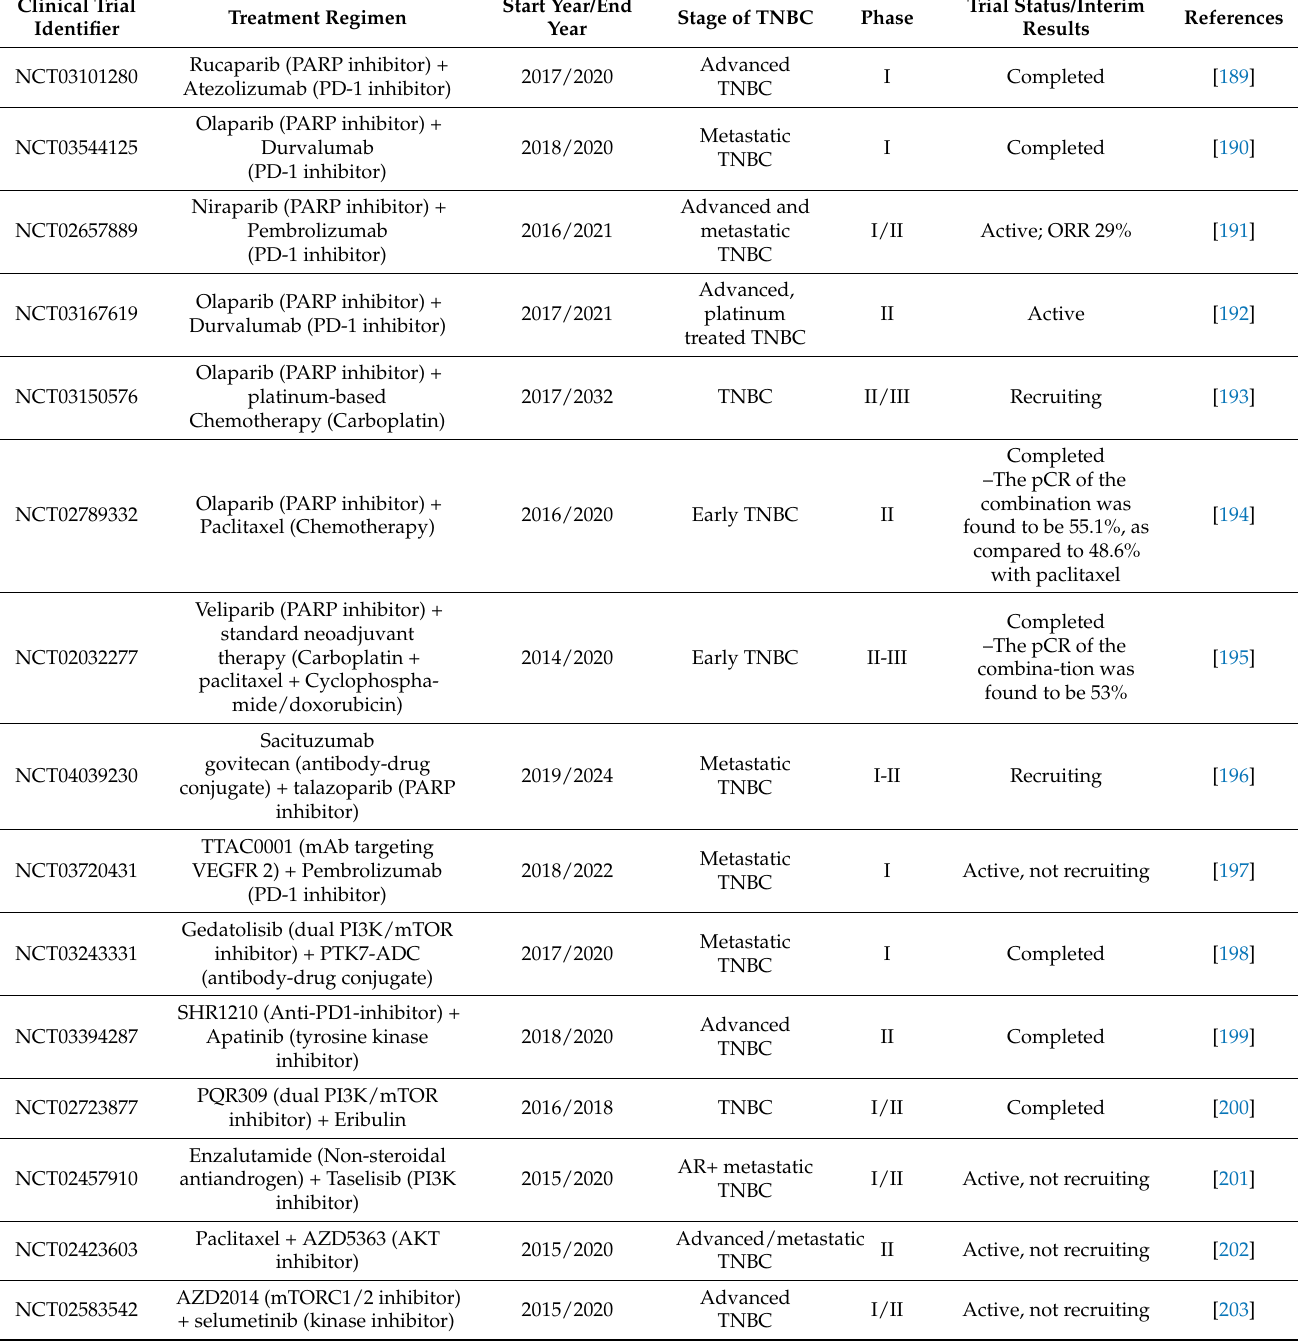
Table 2. Various clinical trials of TNBC using combination